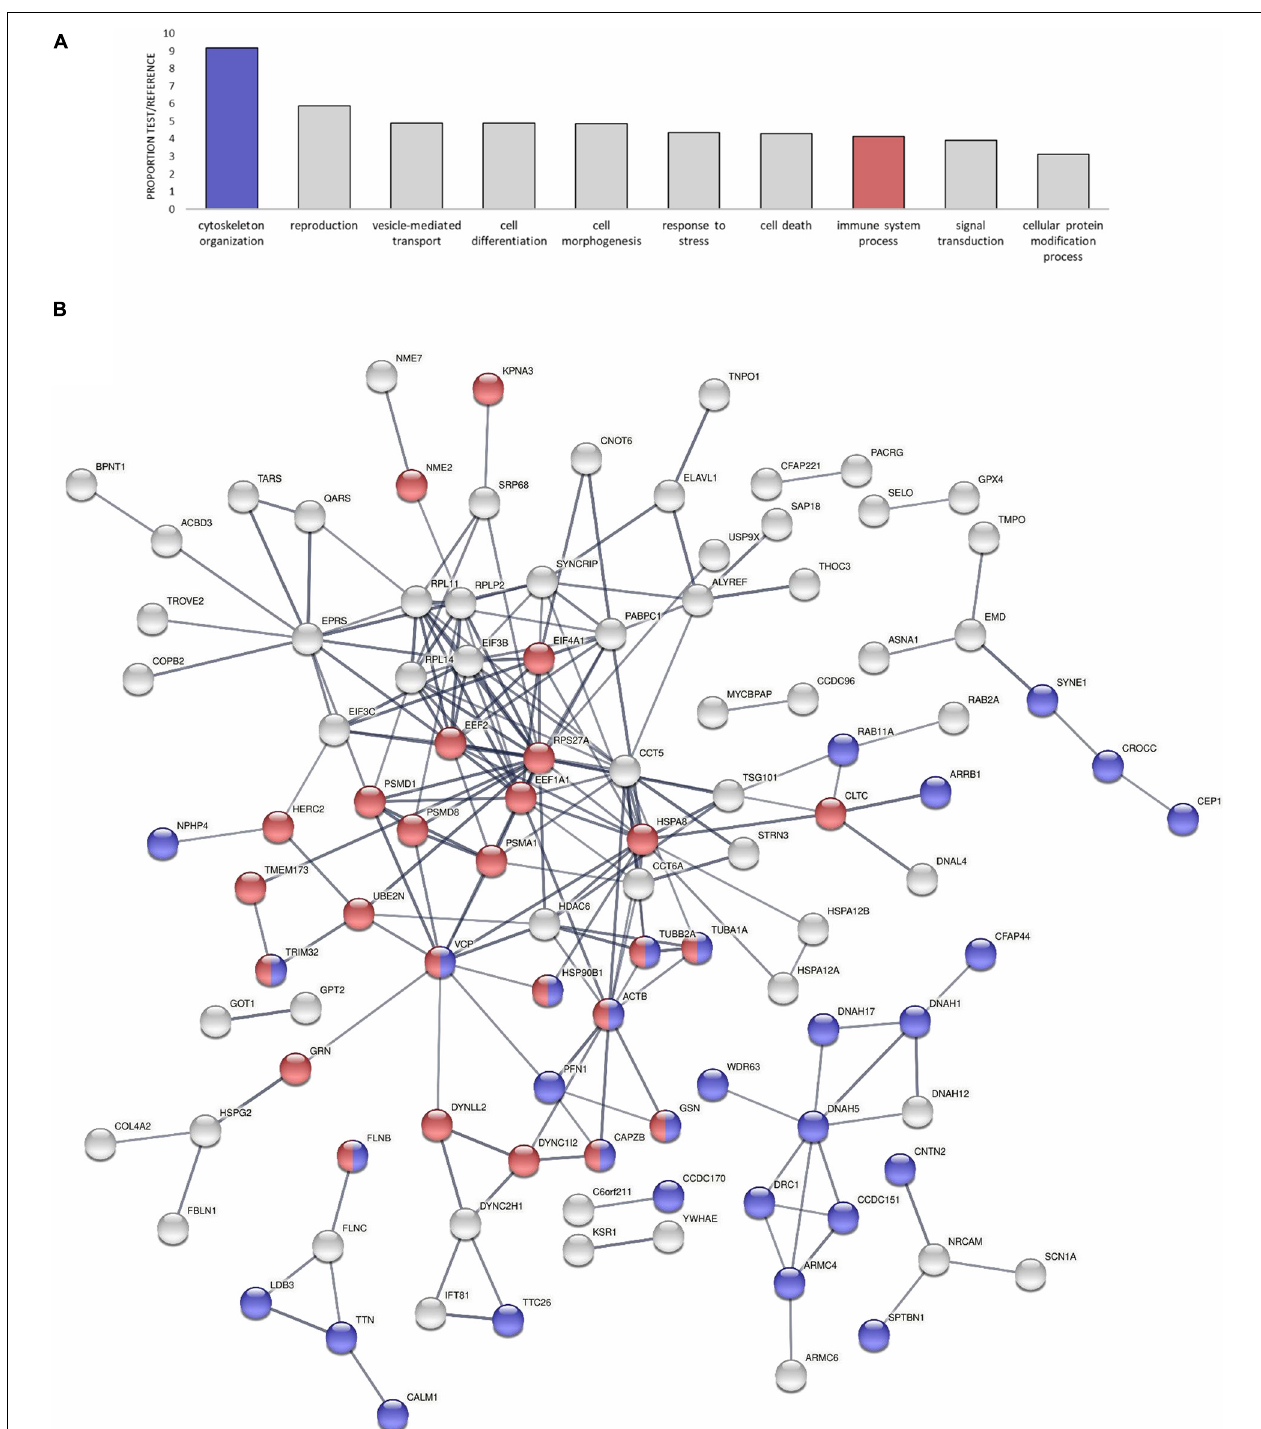
FIGURE 4 | Modulated proteins (DEPs) enriched in cytoskeletal and immune functions could conform to a conserved protein interaction network. (A) GO-Slim Enrichment Analysis of the most present biological processes in the modulated proteins. Biological processes are represented in accordance with their test/reference proportion (test = presence of a particular process in the studied DEPs; reference = presence of a particular process in the whole proteome). Cytoskeletal and immune functions are highlighted because of their importance in the proteomic response. (B) Significant protein interaction net conformed by human homologs to the modulated proteins in the analysis (DEPs). The interaction network is enriched in cytoskeletal and immune-related proteins, which are highlighted in the same color legend as in (A) . The thickness of the lines represents the confidence of each interaction. The legend that indicates to which proteins the symbols of the net correspond is in Supplementary Table 2